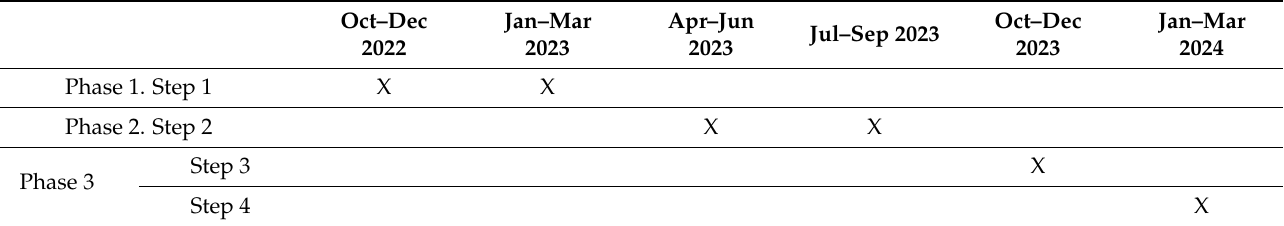
Table 3. Anticipated time line of the